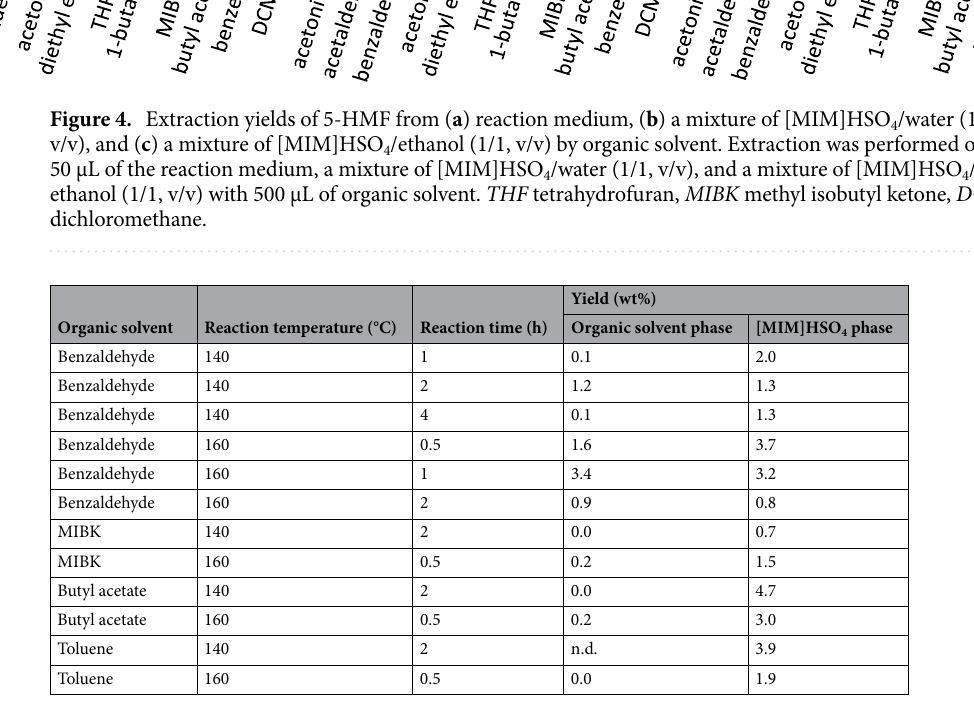
Table 2. Yields of extracted 5-HMF from wood by biphasic ([MIM]HSO 4 /organic solvent) reaction system. Extraction was performed with 6 mL of solvent on a 3 g [MIM]HSO 4 with 0.09 g of wood (moisture content 4.8%) added. n.d. not